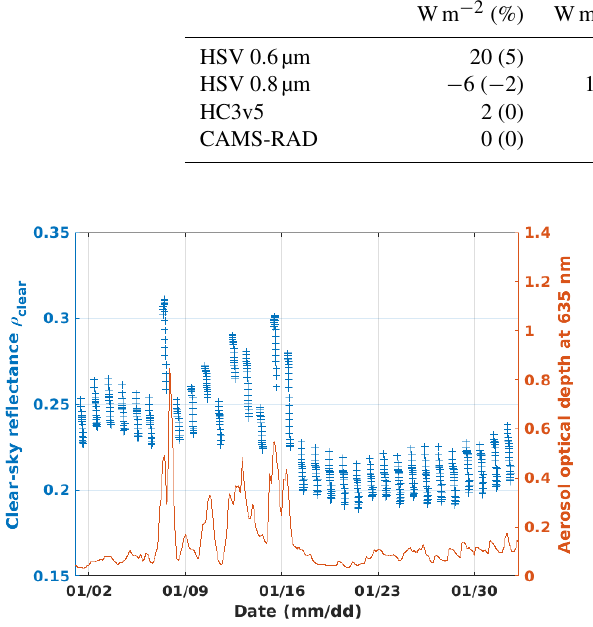
Figure 9. Blue plus signs: simulated reflectances at the top of the atmosphere in clear-sky conditions ρ clear in January 2011 at Cam- borne station (CAM) and for MSG 0.6µm. Red line: aerosol optical depth at 635nm used for